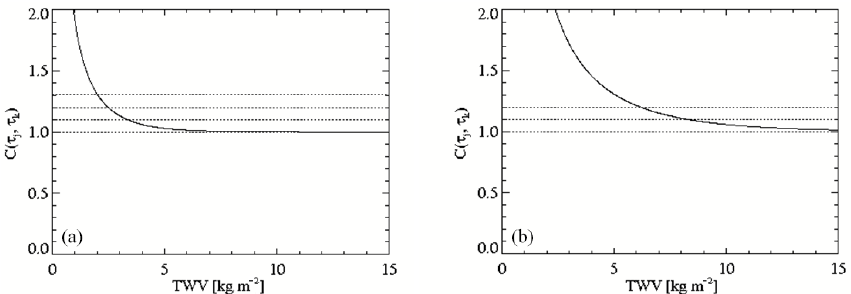
Figure 3. C(τ j ,τ k ) parameter for the mid-TWV algorithm (a) and for extended-TWV algorithm (b) . The dashed horizontal lines represent the variability interval for the C(τ j ,τ k ) parameter inside the TWV range corresponding to each case.